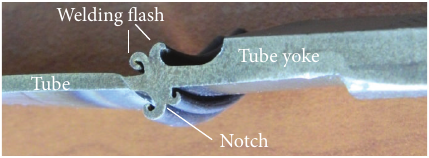
Figure 6: Specimen extracted from the weld